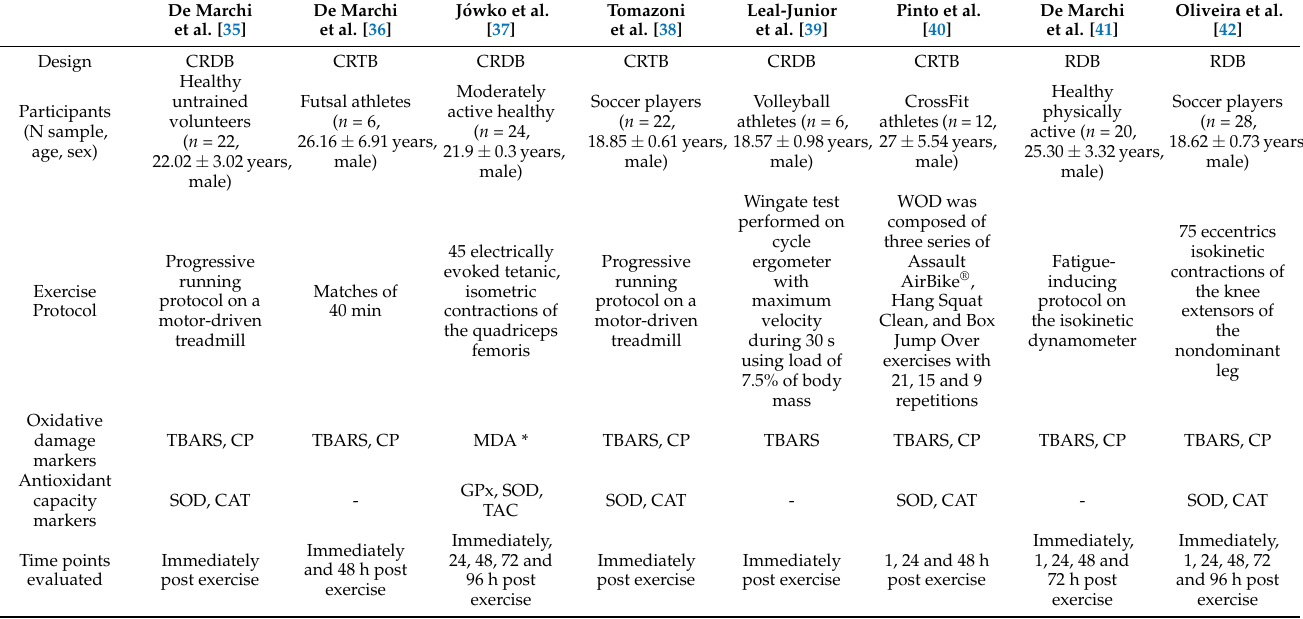
Table 1. Characteristics of included